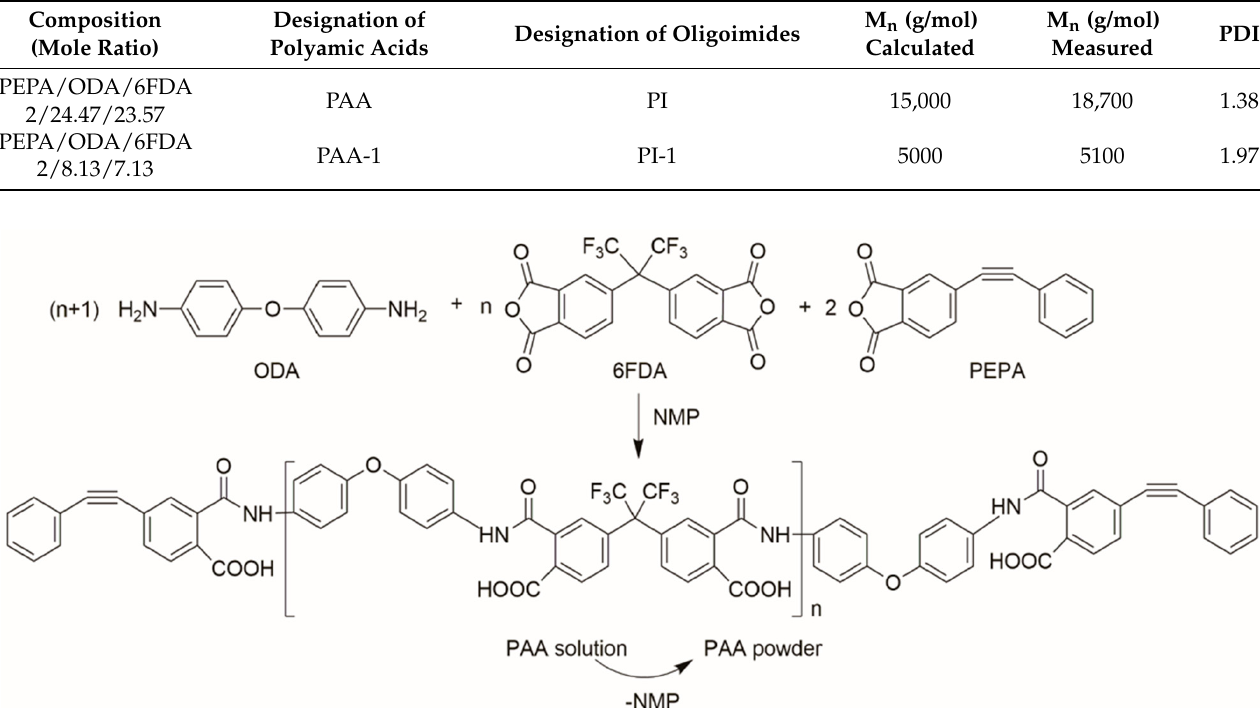
Figure 2. ( a ) 1 H-NMR and ( b ) 13 C-NMR spectra of uncured PI-1; ( c ) the FT-IR of PAA-1 powders, PI- 1, and cured PI-1. 3.2. Three-Dimensional Printing of SiO 2 @TSPI Composites Using Direct Ink Writing (DIW) Proper rheology is vital for DIW technology, and a trade-off between viscosity and high elastic modulus is required to keep the shape during and after extrusion. The rheo- logical properties of the SiO 2 /PAA inks were analyzed using a rheometer. The PAA pow- der was dissolved in DMF to obtain a solution with a concentration of 70 wt%. As shown in Figure 3a, when SiO 2 nanoparticles were added into the PAA solution, the viscosity of the mixture significantly increased compared with the PAA solution and exhibited the characteristic of non-Newtonian fluid. Both the inks of PAA-70% and SiO 2 @PAA-6.2% showed shear thinning behavior. Besides viscosity, the moduli test is another prerequisite for DIW ink. Figure 3b shows the storage modulus (G ′ ) and loss modulus (G ″ ) under dif- ferent shear stresses. We can see that the storage modulus is lower than the loss modulus